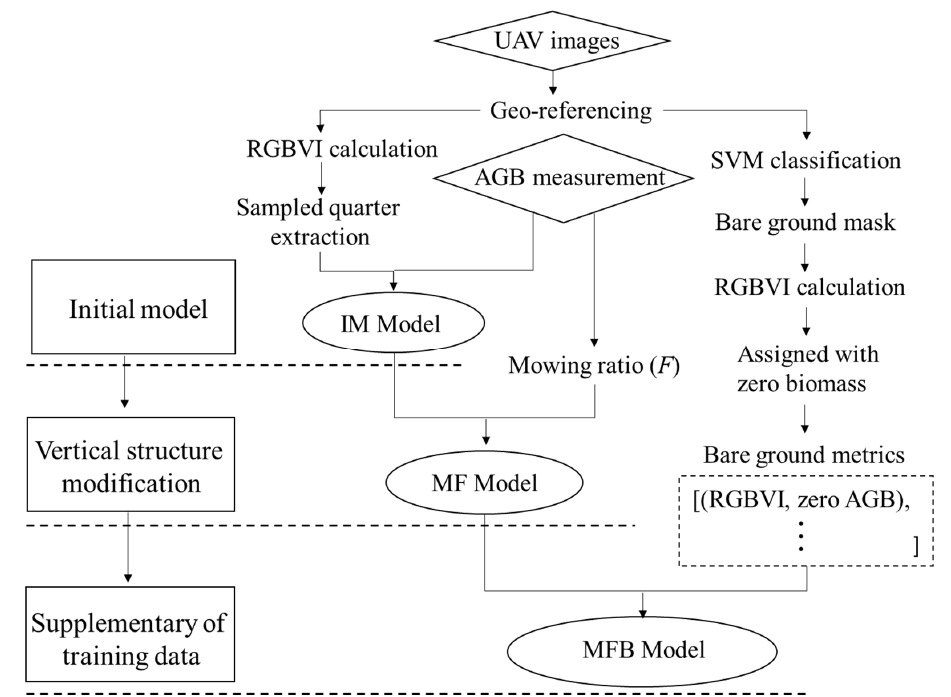
Figure 3. The work flow of the proposed models (IM is the initial model, MF is the mowing ratio modified model, MFB is the model modified by both mowing ratio and bare ground metrics).